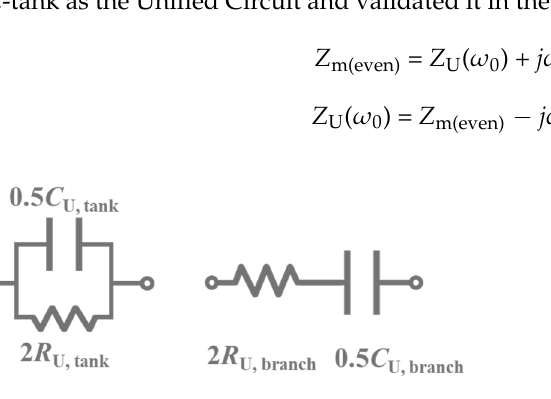
Figure 5. Two types of Unified Circuits. Left is the RC -tank, and right is the RC -branch.